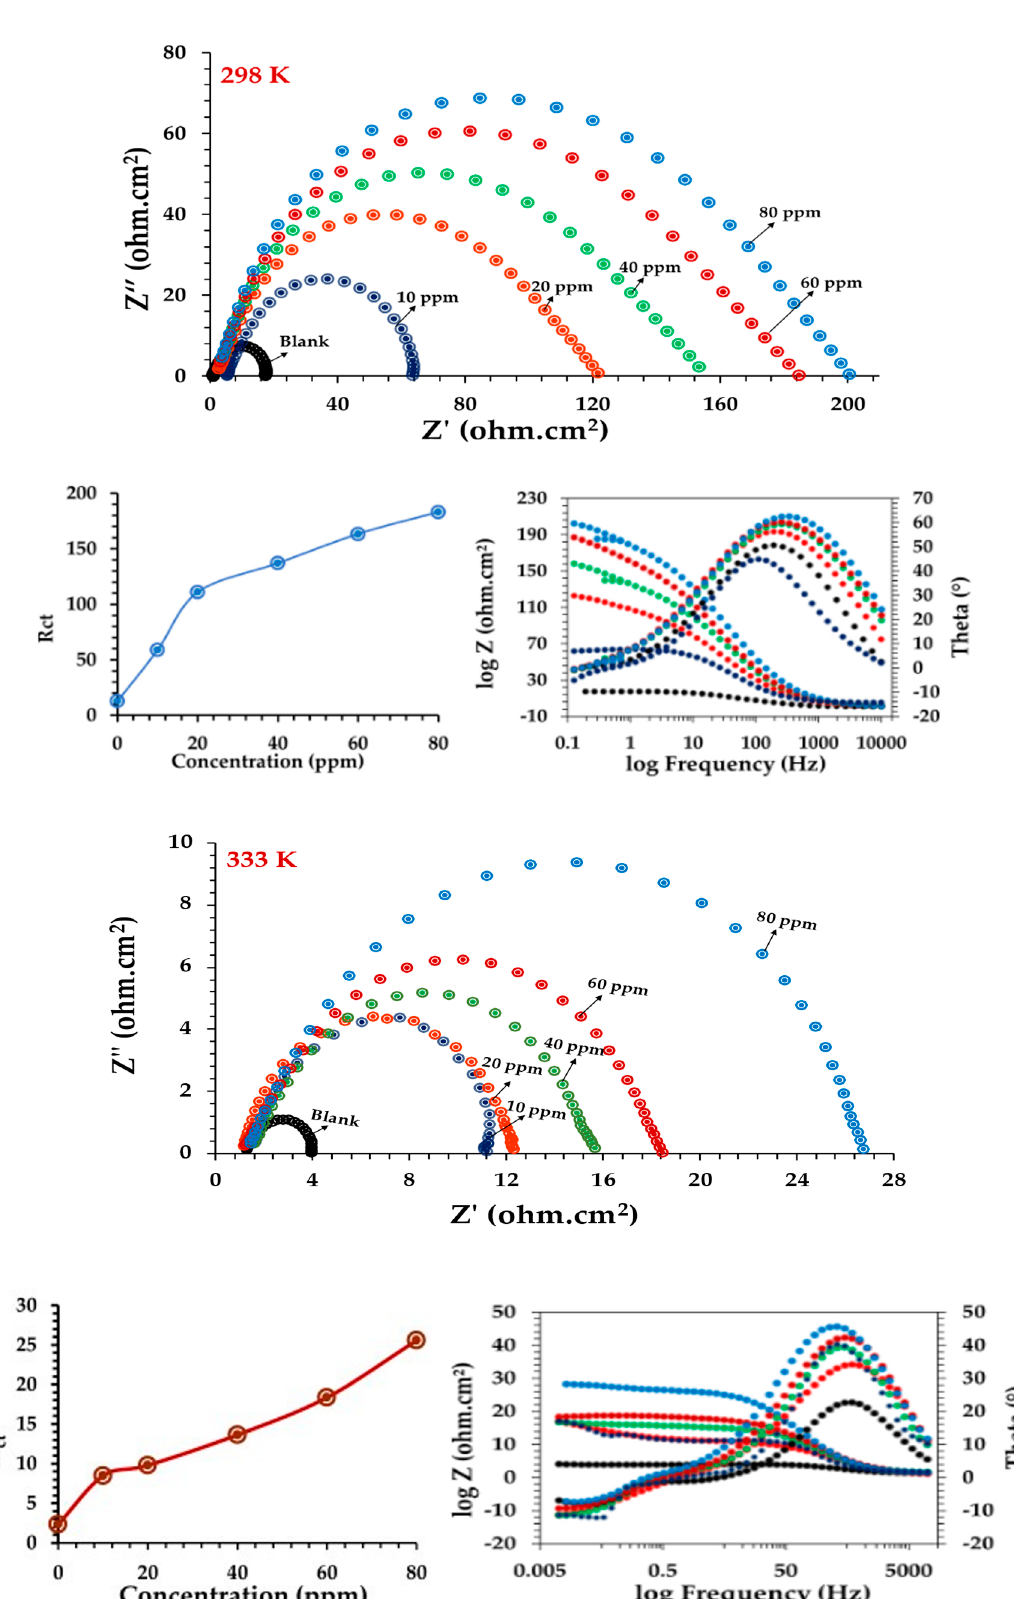
Figure 7. EIS diagrams of low-carbon steel corrosion in 1 M HCl in the absence and presence of CoO/Co 3 O 4 NPs at 298 and 333 K after immersion for 30 min.